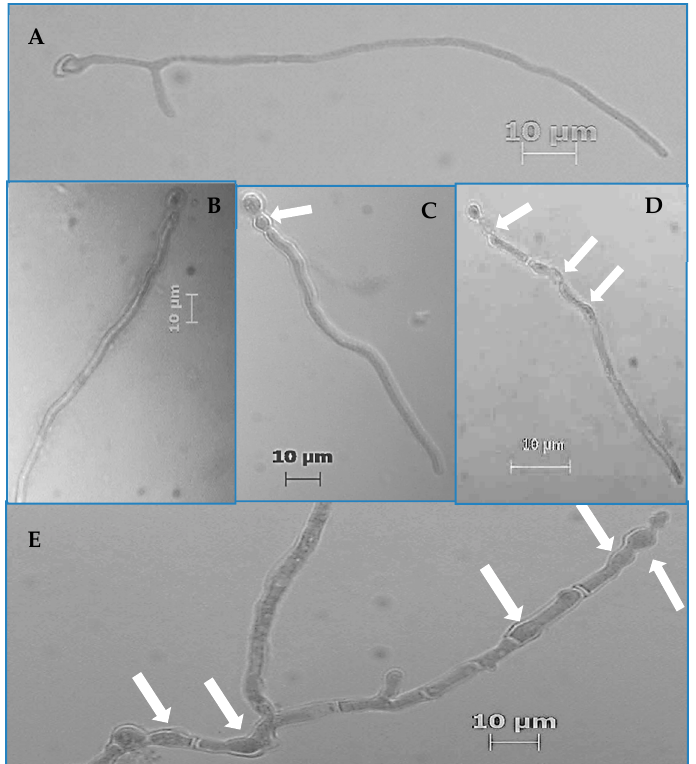
Figure 1. Examples of the various fungal morphologies encountered in germination and adhesion assays. ( A) Reverse osmosis water (ROH 2 O) (control) treated fungi; ( B – E ) Different morphologies observed in A. striata treated Pv19; ( B ) swollen with parallel cell walls (SP), ( C ) swollen with non-parallel cell walls in the sub-conidial hyphal region (SNPSC), ( D ) swollen with non-parallel cell walls up to the midpoint hyphal region (SNPM), and ( E ) swollen with non-parallel cell walls throughout the hyphal length (SNPL). Arrows point to locations on hyphae where non-parallel cell walls are present. All statistical analyses were carried out in R [45]. Germination and aberration frequency data were analyzed using logistic regression. Germ tube length data were analyzed via ANOVA. Hyphal and conidial diameter data were analyzed using linear mixed-effects model via the lme4 package [46,47]. Adhesion assay results were analyzed using the Mann-Whitney Rank Sum